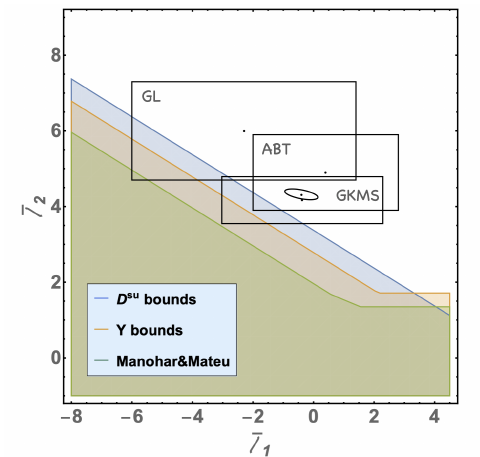
¯ ¯ l 1 and l 2 . The colored